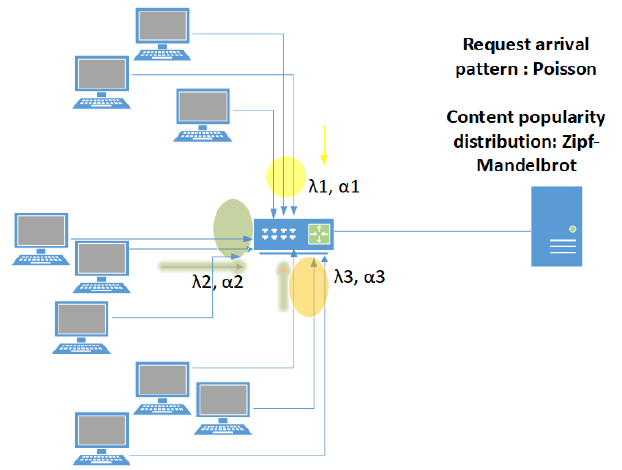
Figure 3. Illustration of the demand model.